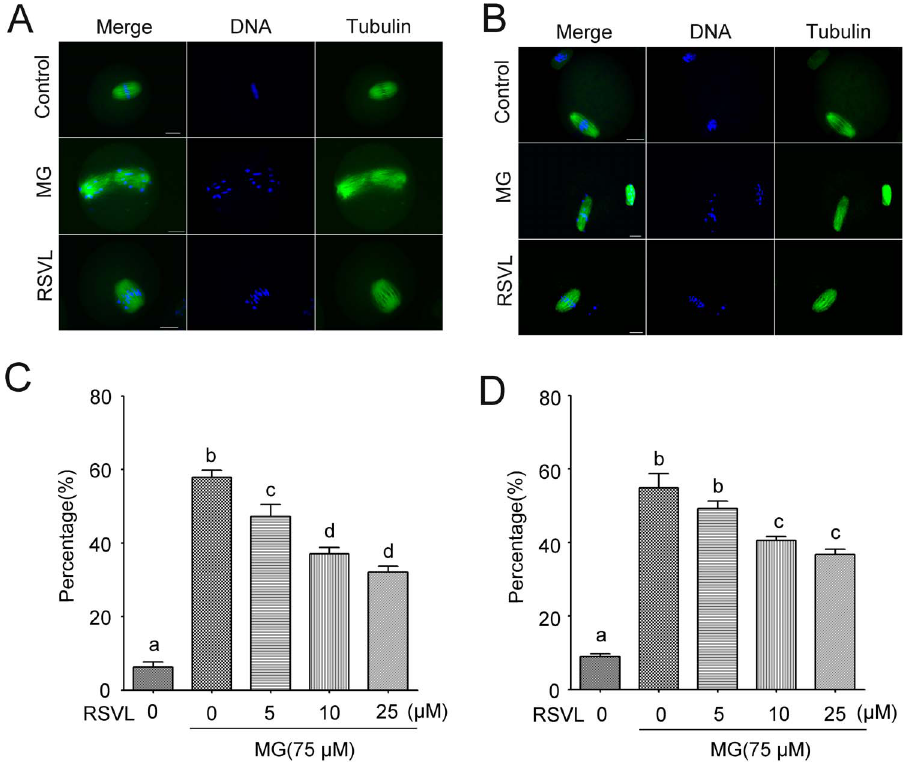
Figure 3. Effect of MG and resveratrol on spindle formation and chromosome alignment of MI and MII oocytes. ( A ) Representative sample of control group, MG-treated group and RSVL-MG-treated group possessing various shapes of MI spindle (green) and chromosomes (blue). Normal spindles displayed a typical shuttle shape and located to the periphery of the oocyte. Chromosomes were aligned exactly on equatorial plate. MG can obviously induce a deformation of spindle and a disturbance of chromosome alignment and this abnormal morphology can be prevented by resveratrol. ( B ) Representative sample of control group, 75 m M MG-treated group and RSVL-MG-treated group possessing various shapes of MII spindle and chromosomes. Scale bar =20 m m. ( C ) and ( D ) Percentage of oocytes with abnormal spindle and misaligned chromosomes in MI and MII oocytes from control group, MG-treated group and different concentrations of RSVL-MG-treated group (5, 10 and 25 m M). Data are mean 6 SEM of three independent experiments. Different letters denote statistically significant differences ( P , 0.05)